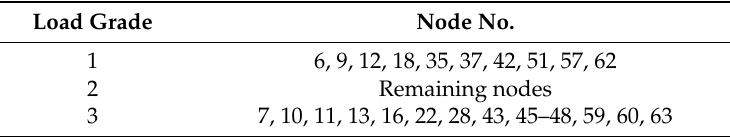
Table 2. Types of loads.